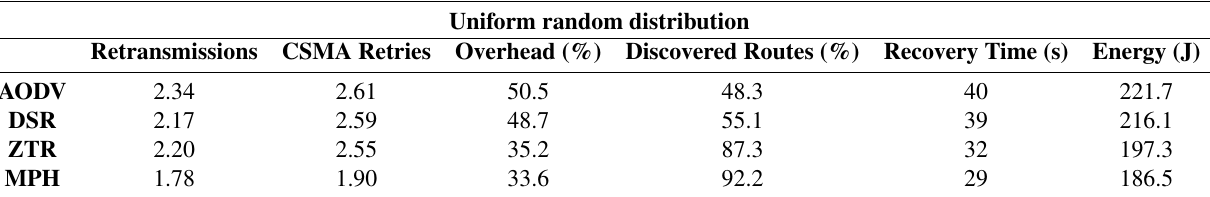
Table 7. Uniform Random